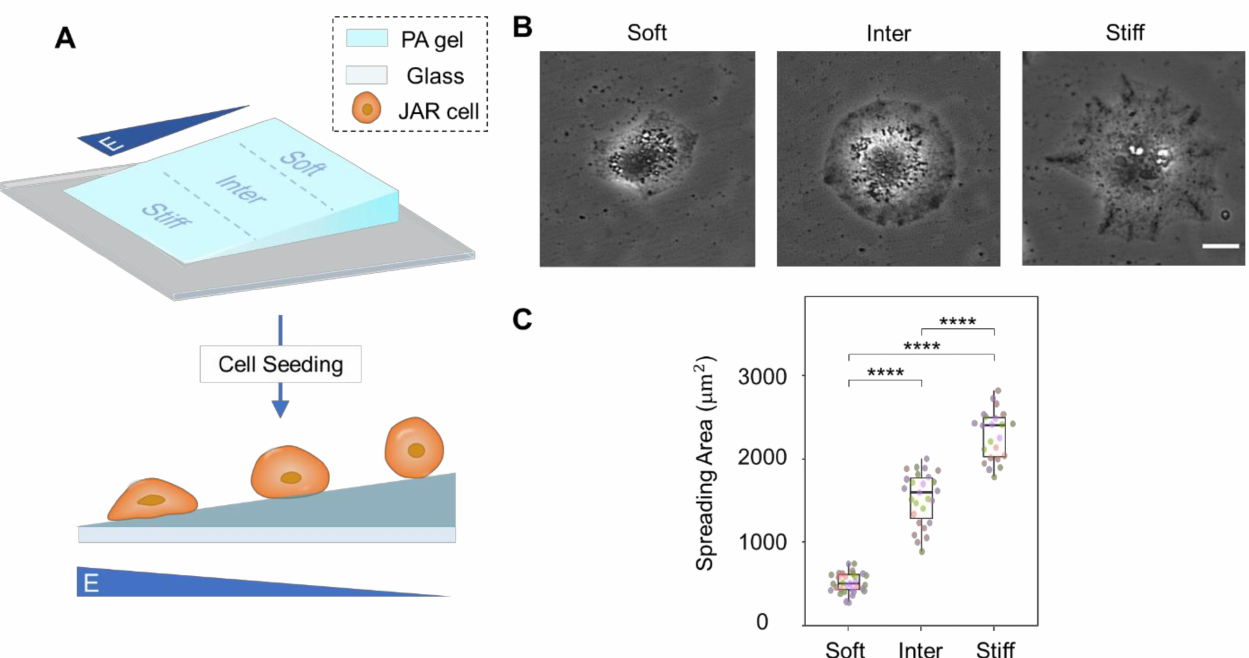
Figure 1. Simulated ECM stiffness regulates trophoblast cell morphology and spreading area. ( A ) ( Top ): schematic diagram of PA gel with stiffness gradient. The Young’s modulus of the PA gel is 1 kPa, and its apparent Young’s modulus gradually increases with the decrease in the gel thickness. According to the change of the apparent Young’s modulus, the surface of the PA gel is evenly divided into three regions, namely Stiff, Intermediate, and Soft. ( Bottom ): schematic representation of JAR cells cultured on different regions. E indicates the apparent Young’s modulus. ( B ) Phase contrast images of JAR cells cultures on different regions scale bar: 20 µ m. The yellow dashed line indicates the boundary of cells. ( C ) Measured average cell spreading area of JAR cells cultured on different regions. **** p < 1 × 10 − 6 , n = 31, 27, 23 for Soft, Inter and Stiff, respectively. Data reported as mean ± standard deviation for N = 3 independent experiments. Each scatter indicates each cell being measured, and each color indicates an independent